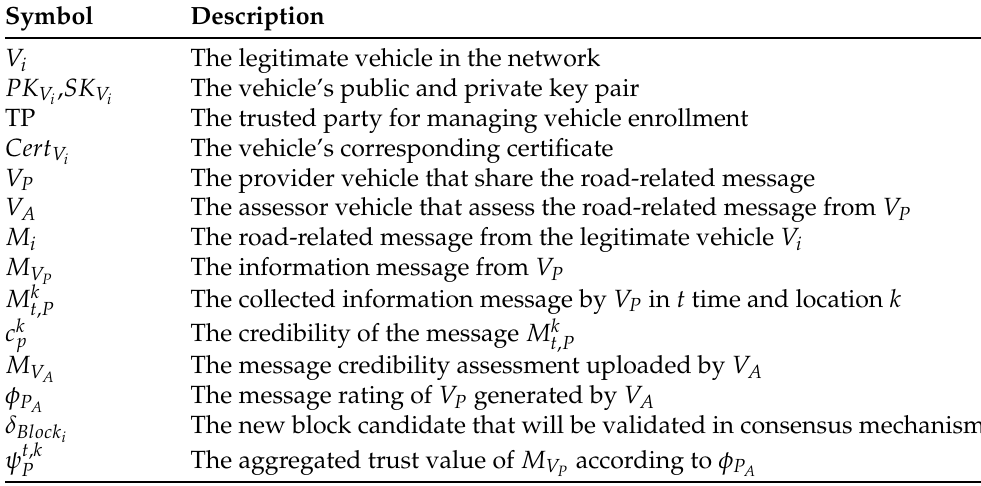
Figure 1. Overview of proposed model. Table 1. Summary of